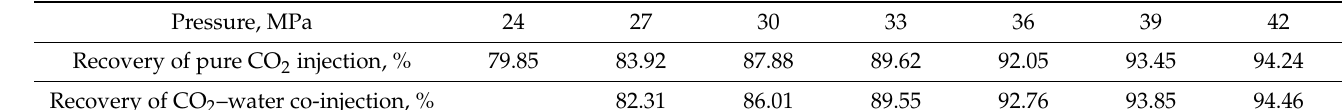
Figure 16. The relationship between the molar content of CO 2 in flash gas of crude oil and CO 2 injection molar quantity at different water contents.